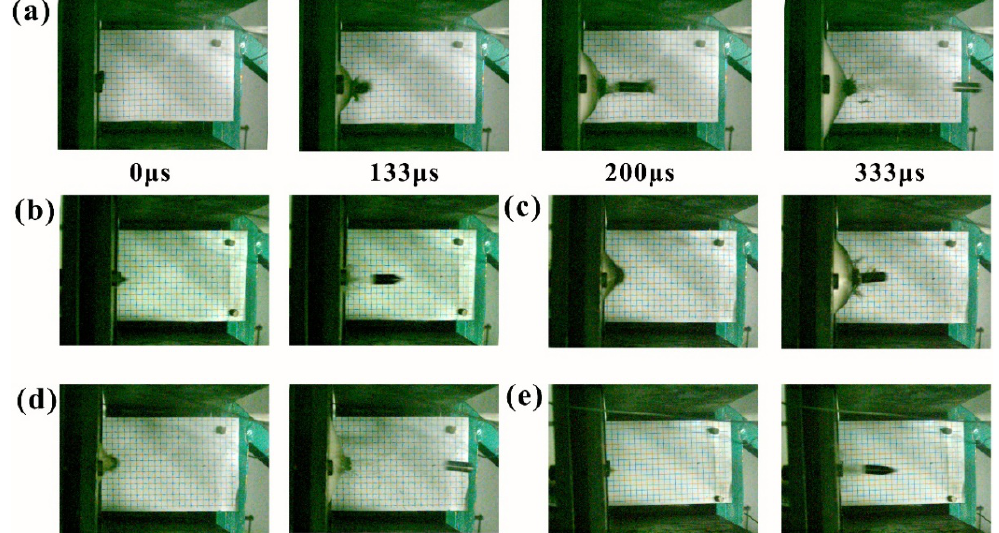
Figure 3. The deformation process of the UHMWPE laminate impacted various projectile nose shapes. ( a – e ) were flat, 60°, 120°, hemispherical, and ogival nose shape projectile, respectively. The deformation process of the UHMWPE laminate varied with the projectile